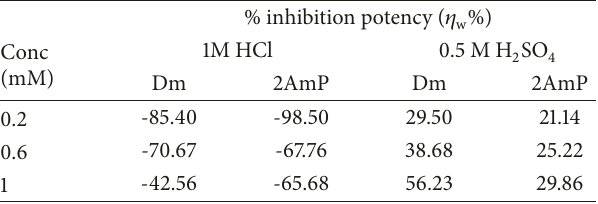
Table 2: The corrosion inhibition potency of parent ketone